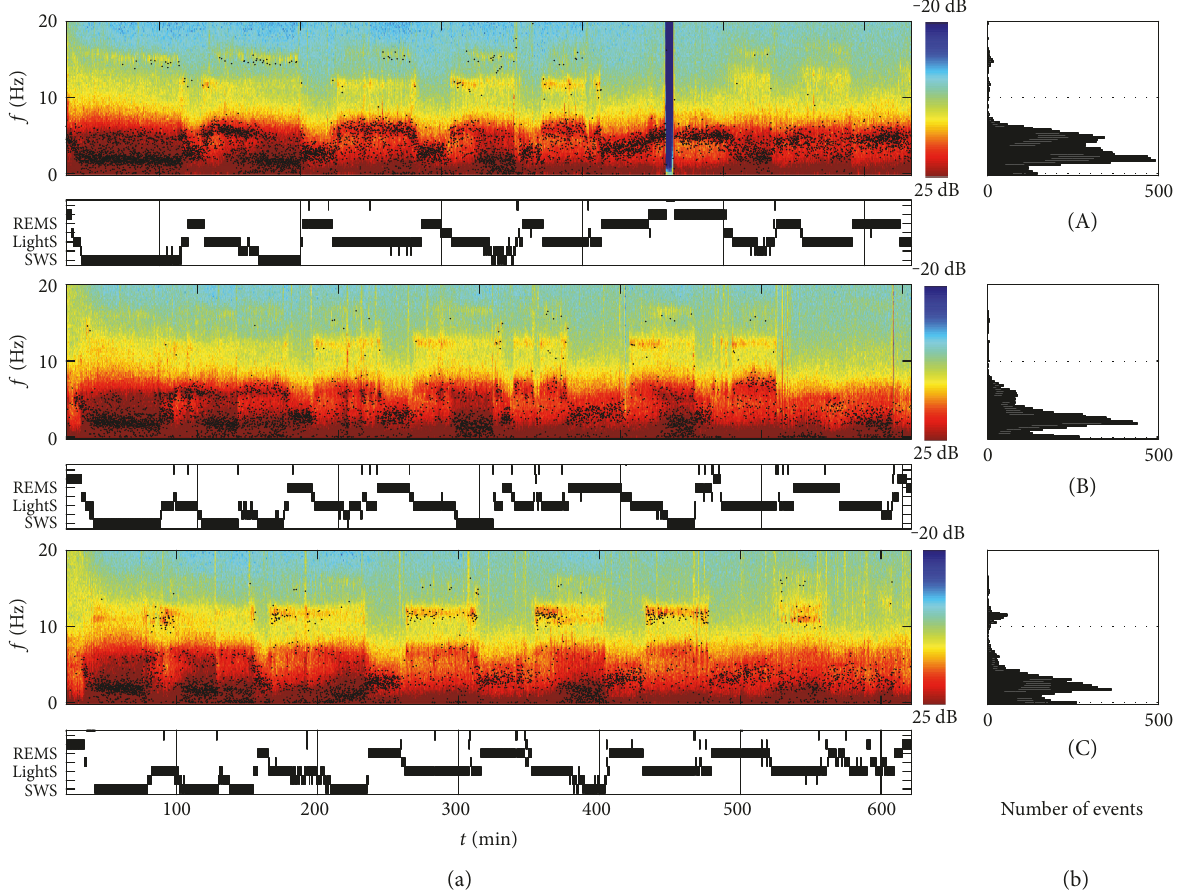
Figure 1: Spectrograms, oscillatory events (derivation C3A2), and hypnograms of a boy (same child shown in Supplementary Figure S 1 ) recorded longitudinally at ages 2 years (A), 3 years (B), and 5 years (C). For each recording, the following data are illustrated. (a) — top: spectrogram and superimposed oscillatory events (black dots). Spectra are color coded on a logarithmic scale (0 dB=1 μ V 2 /Hz). (b) Frequency distribution of oscillatory events. (a) — bottom: hypnogram (REMS: REM sleep; LightS: NREM sleep stages 1 and 2; SWS: NREM sleep stages 3 and 4). The dark blue bar re fl ects a short disconnection of the